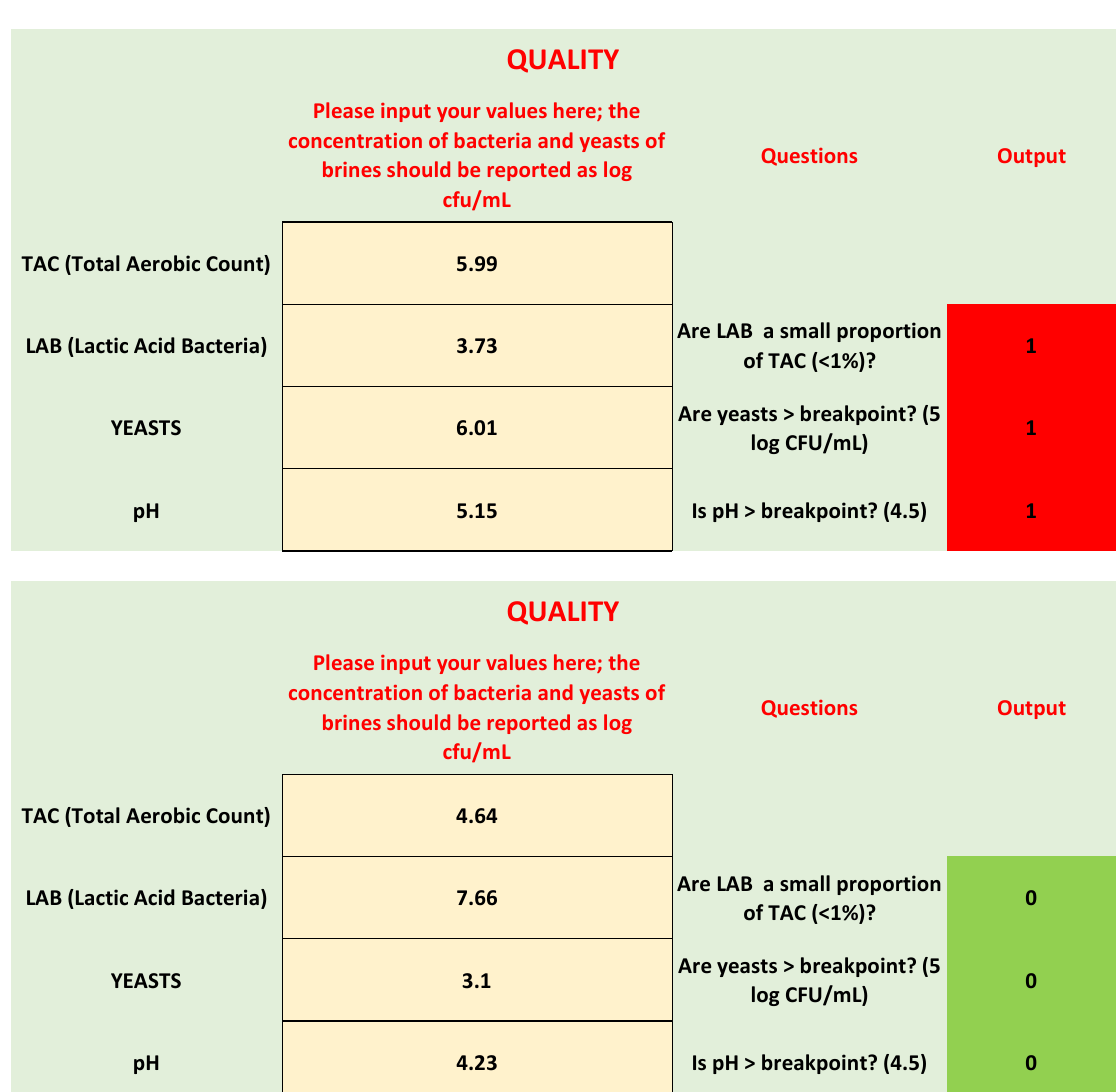
Figure 6. Traffic light for spoiled (sample 2) and acceptable samples (sample 6). Figure 6. Tra ffi c light for spoiled (sample 2) and acceptable samples (sample